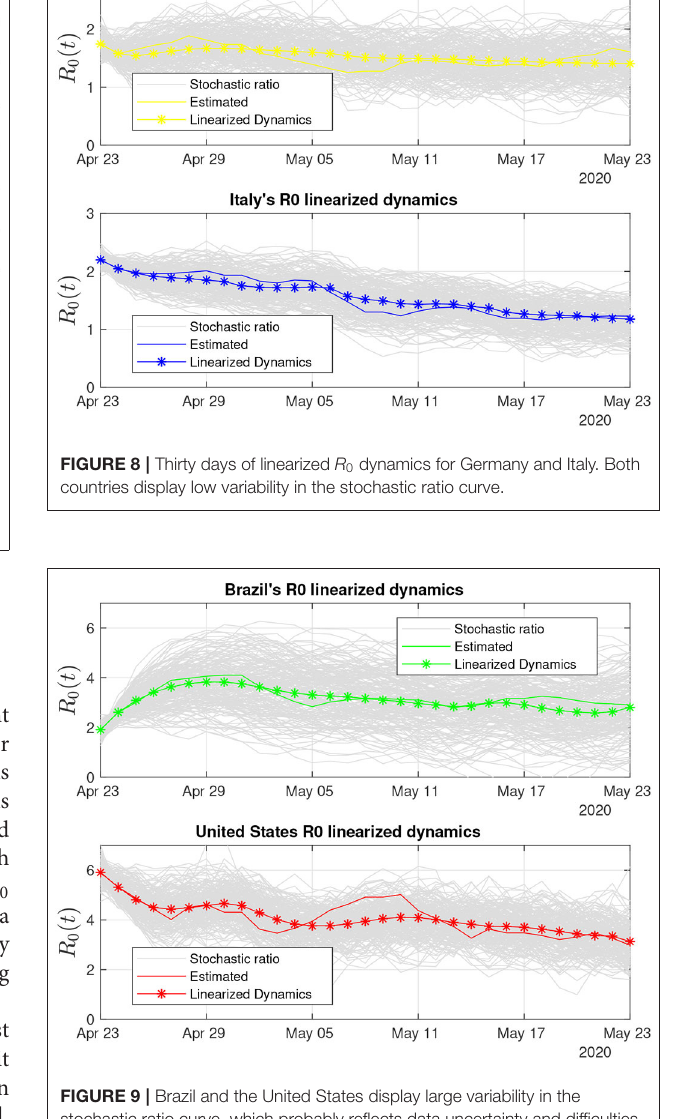
FIGURE 9 | Brazil and the United States display large variability in the stochastic ratio curve, which probably reflects data uncertainty and difficulties to control COVID-19’s